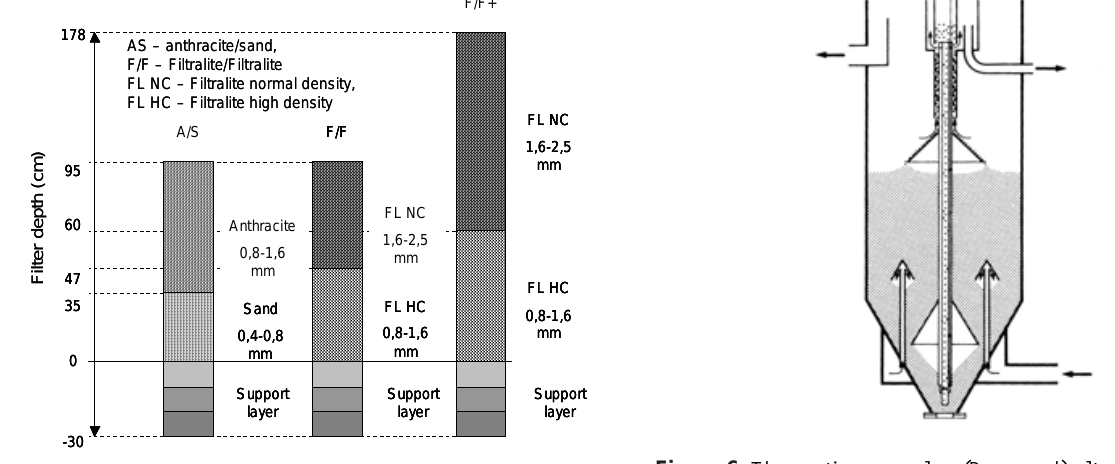
Figure 4. The mono-multi Filtralite filter.